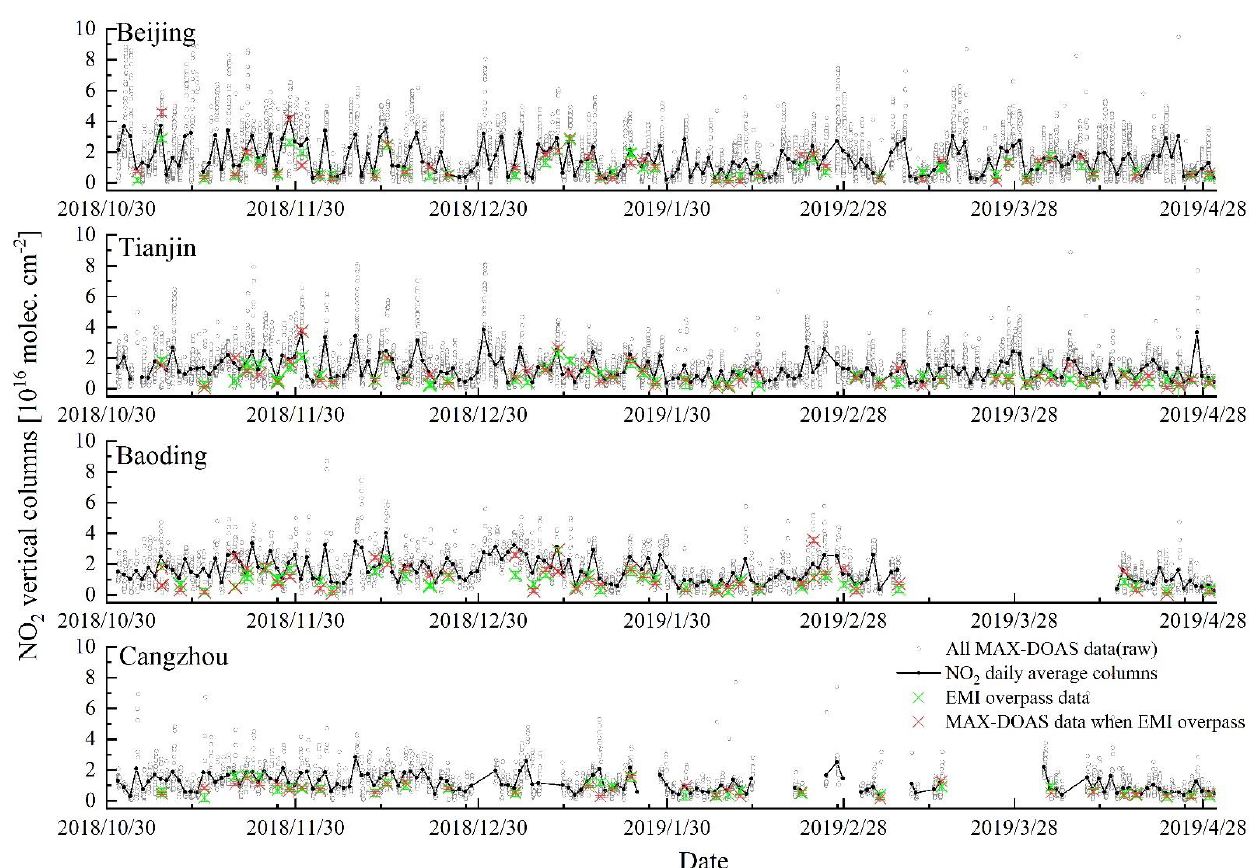
Figure 6. Time series of MAX-DOAS and EMI tropospheric NO 2 VCDs from November 2018 to April 2019. The gray dots are the raw tropospheric NO 2 amounts continuously observed by MAX-DOAS, and the red and green marks are the average columns of MAX-DOAS in 60 minutes and the monitoring columns obtained by EMI respectively, around the time of the GF-5 overpass.